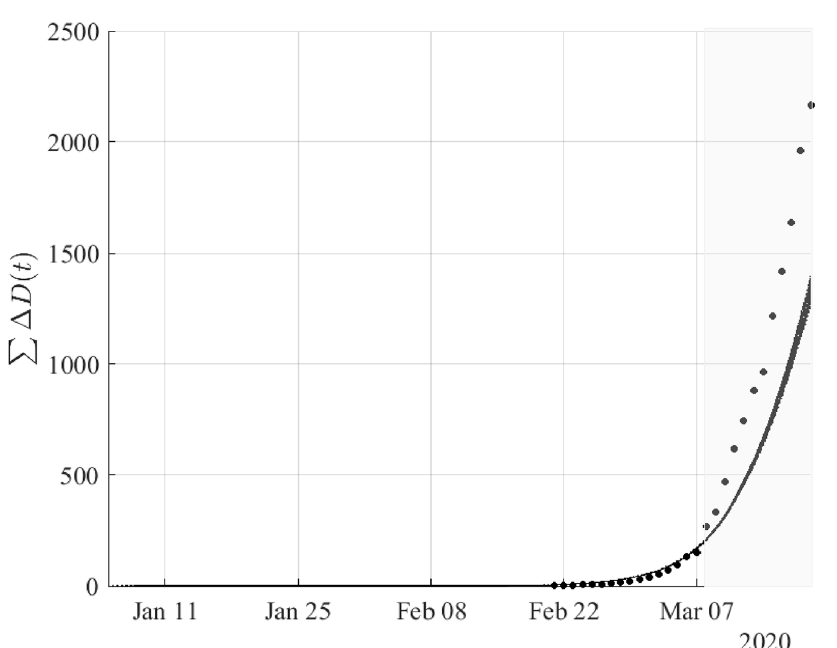
Fig 4. Cumulative number of deaths resulting from simulations based on the results obtained by fitting the daily new cases of deaths from February 21 until the 8th of March. The validation of the model was performed using the reported data of confirmed cases from March 9 to March 19 (shaded area) by taking (1-0.4)(1-0.2) reduction in the “effective” transmission rate (see in Methodology) to the lockdown of March 8. Dots correspond to the reported data of confirmed deaths.